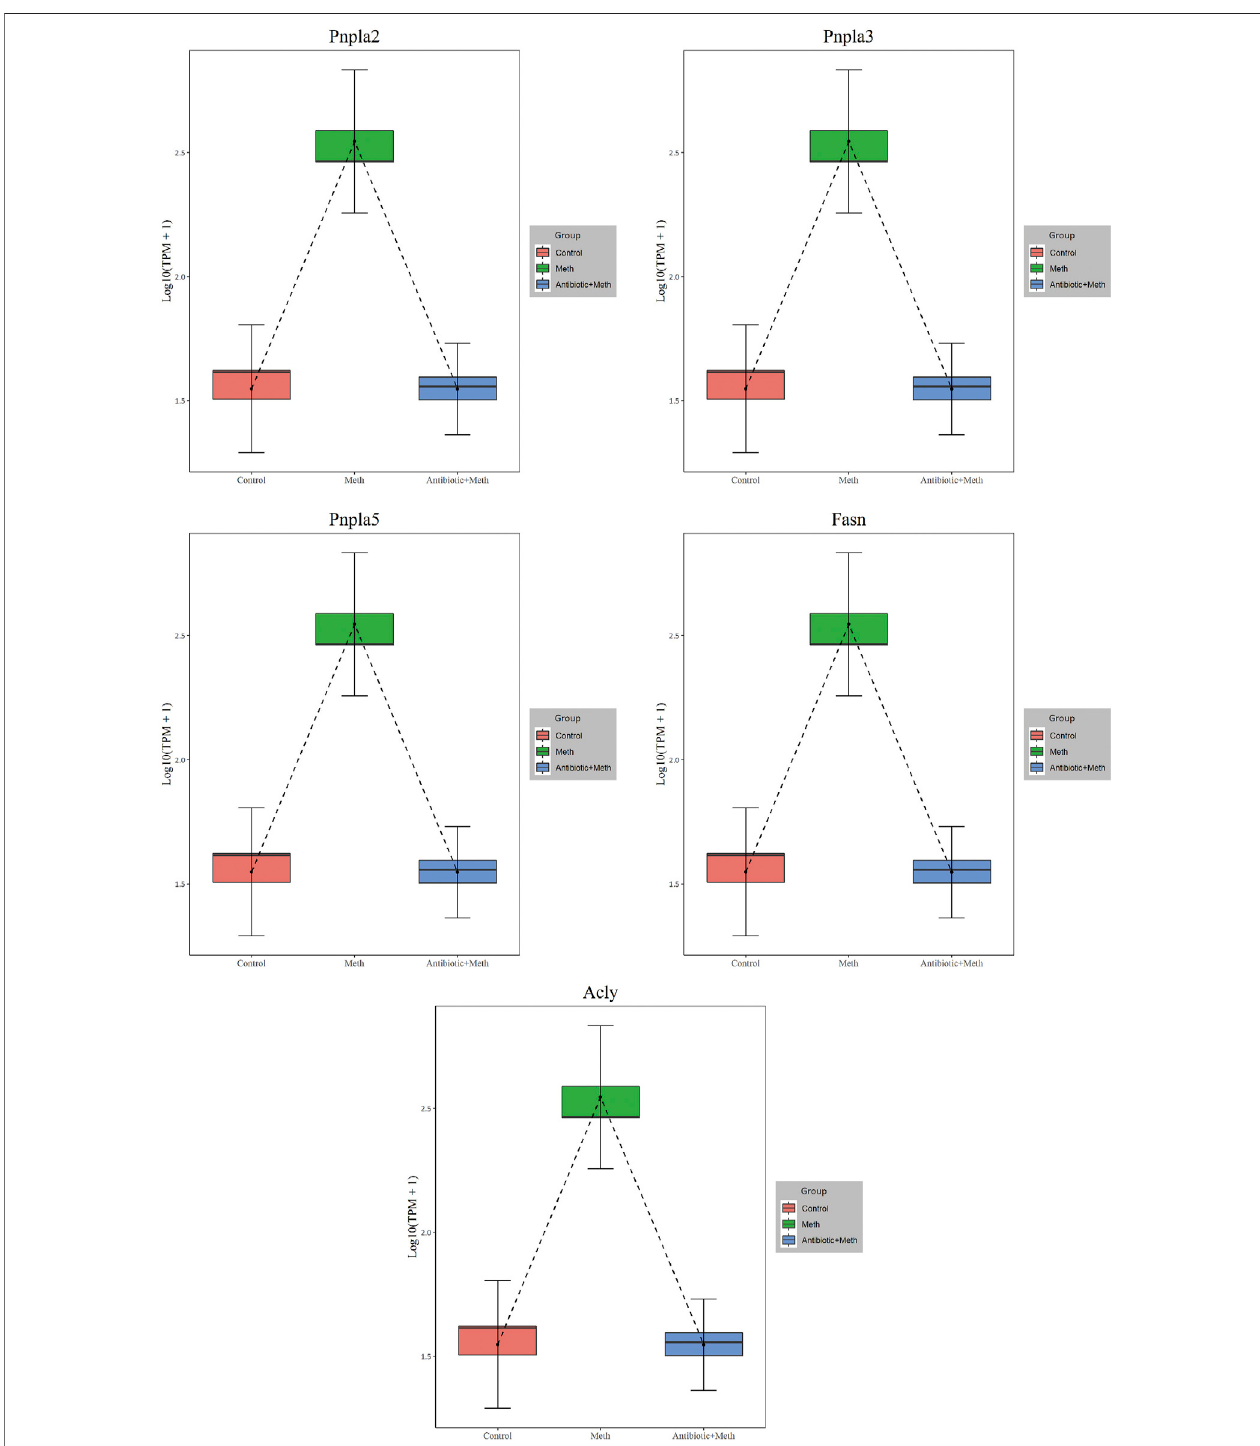
FIGURE 6 | Expression of hub genes in